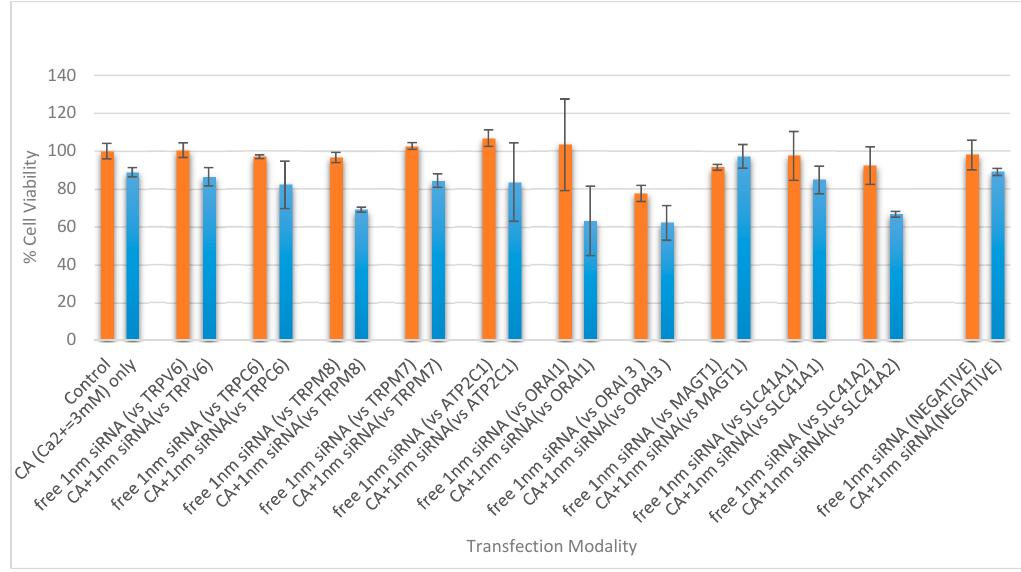
Figure 7. Cell viability assessment of MCF-7 cells treated with NP-siRNA complex and unbound siRNA, where the NP is CA formed with 4.0 mM exogenous CaCl 2 . The cells were treated with media (negative control) or NPs formed with 4.0 mM of exogenous CaCl2 (CA only), and were compared with different siRNA against cation channels and transporter proteins, of 1 nM concentration, both free and bound to the inorganic NP. After 44 h of treatment, cell viability was measured by MTT assay. Values are represented as the mean % of cell viability ± SEM, when compared to untreated cells, where N = 3. Values are presented as the mean ± SD of % of cell viability compared to untreated cells for triplicate samples.